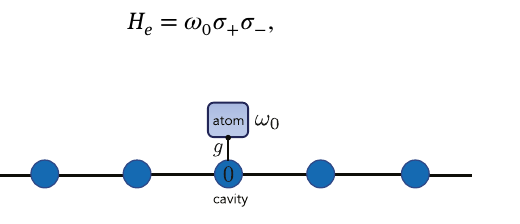
Figure 1: Schematic sketch of the considered model: a two-level quantum emitter (atom) coupled with strength g to a photonic bath B (field) modelled as a set of coupled cavities. The coupling is local in that the atom is directly coupled to only one cavity (labelled with 0). Here, B is represented as a simple one-dimensional lattice (although our framework applies to a generic